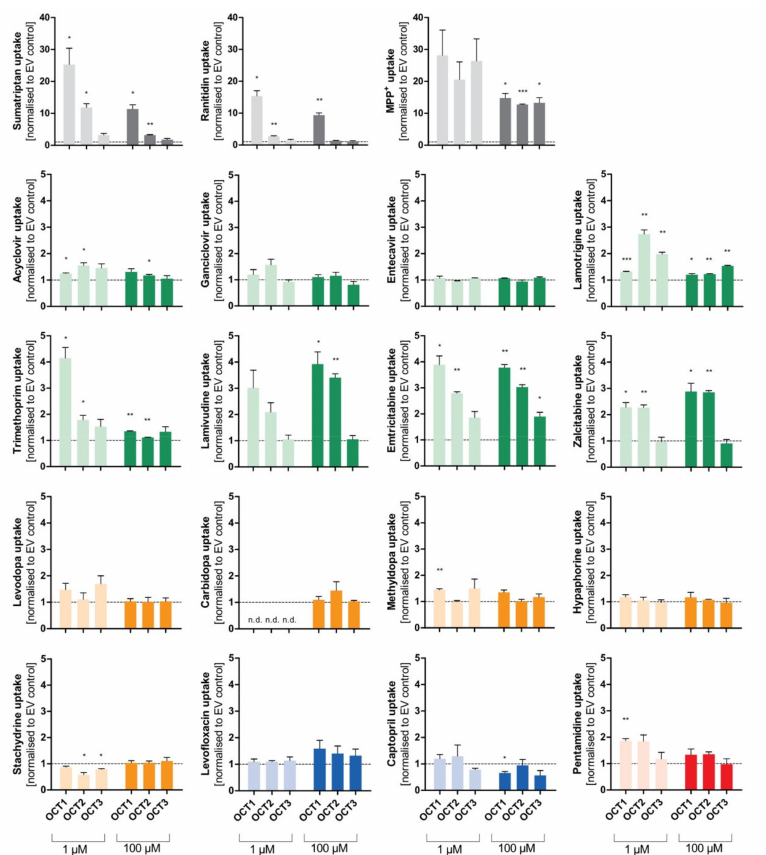
Figure 7. Comparison of transport via OCT1, OCT2, and OCT3. Cellular uptake ratios were per- formed with HEK293 cell lines that were transfected stably with the OCT1, OCT2, and OCT3 transporters, respectively, and that were incubated with 1 µ M (light colour) and 100 µ M (dark colour) of each substance for their specific incubation time (Table 1). The abbreviation “n.d.” indicates that the intracellular substrate concentration was below limit of quantification (not detected). The uptake by OCT1, OCT2, and OCT3 was normalised to the uptake by the empty vector, and zero net transport is indicated with a dotted line. The experiments were conducted at least three times (n ≥ 3) independently (i.e., in different experiments) for every substance. Statistical significance between empty vector-transfected cells and OCT1/2/3, respectively, was determined using a one-sample t -test comparing each of the transport activities of the 3 transporters and the tested substrates with the ratio of 1.0 meaning zero net transport (* p < 0.05, ** p < 0.01, and *** p < 0.001). Thus, we did